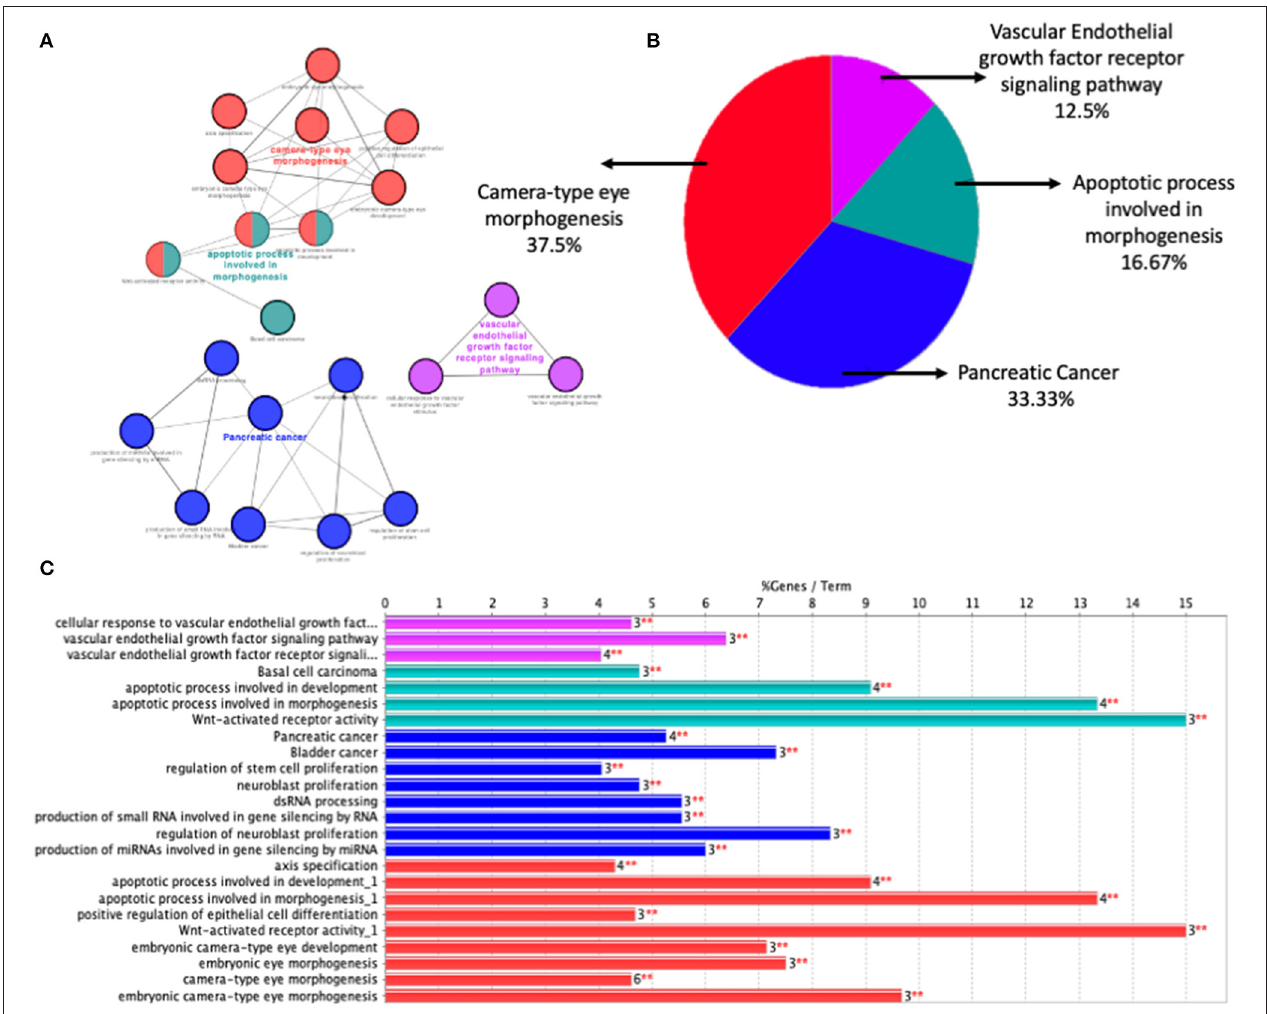
FIGURE 7 | Function analysis of the 14 core genes in module 1 and module 2. (A) Functions and pathways of the core genes were visualized using ClueGO. (B) Distribution of the functions and pathways among the core genes. (C) KEGG pathways and enriched GO terms, colors are assigned to each pathway. Corrected P < 0.01 was considered statistically